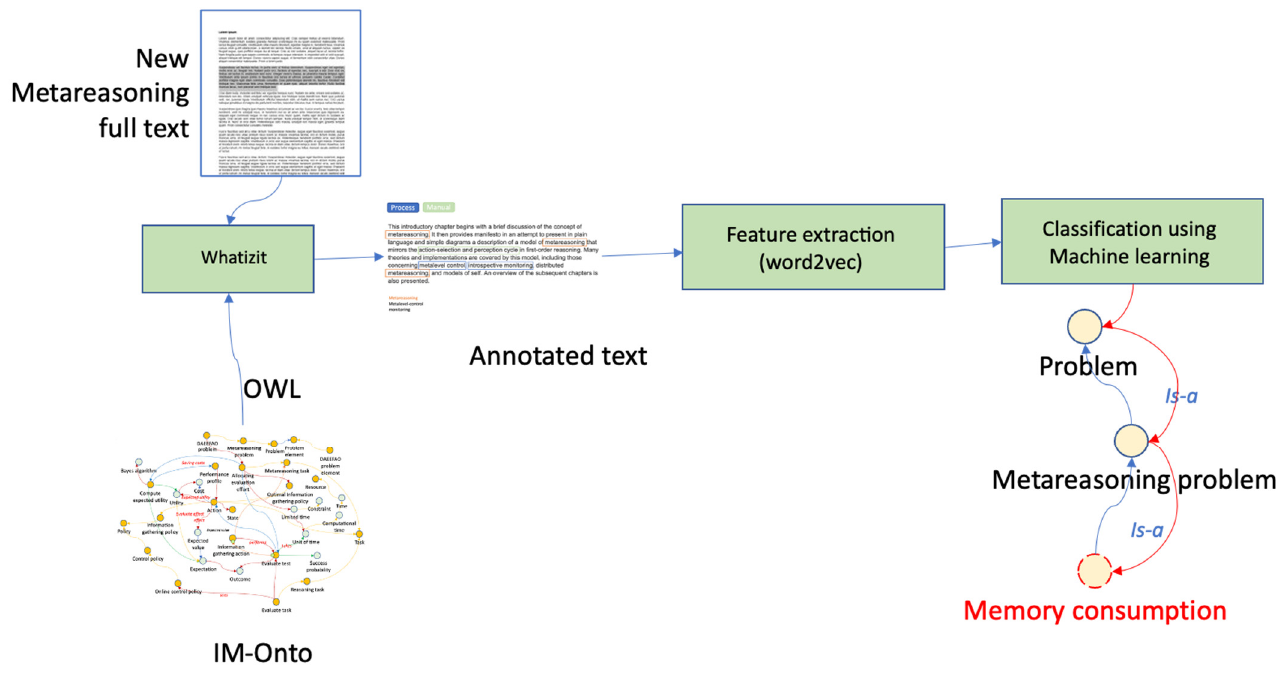
Figure 13. Semi-automated approach to creating new subontologies based on (Althubaiti et al. 2020).